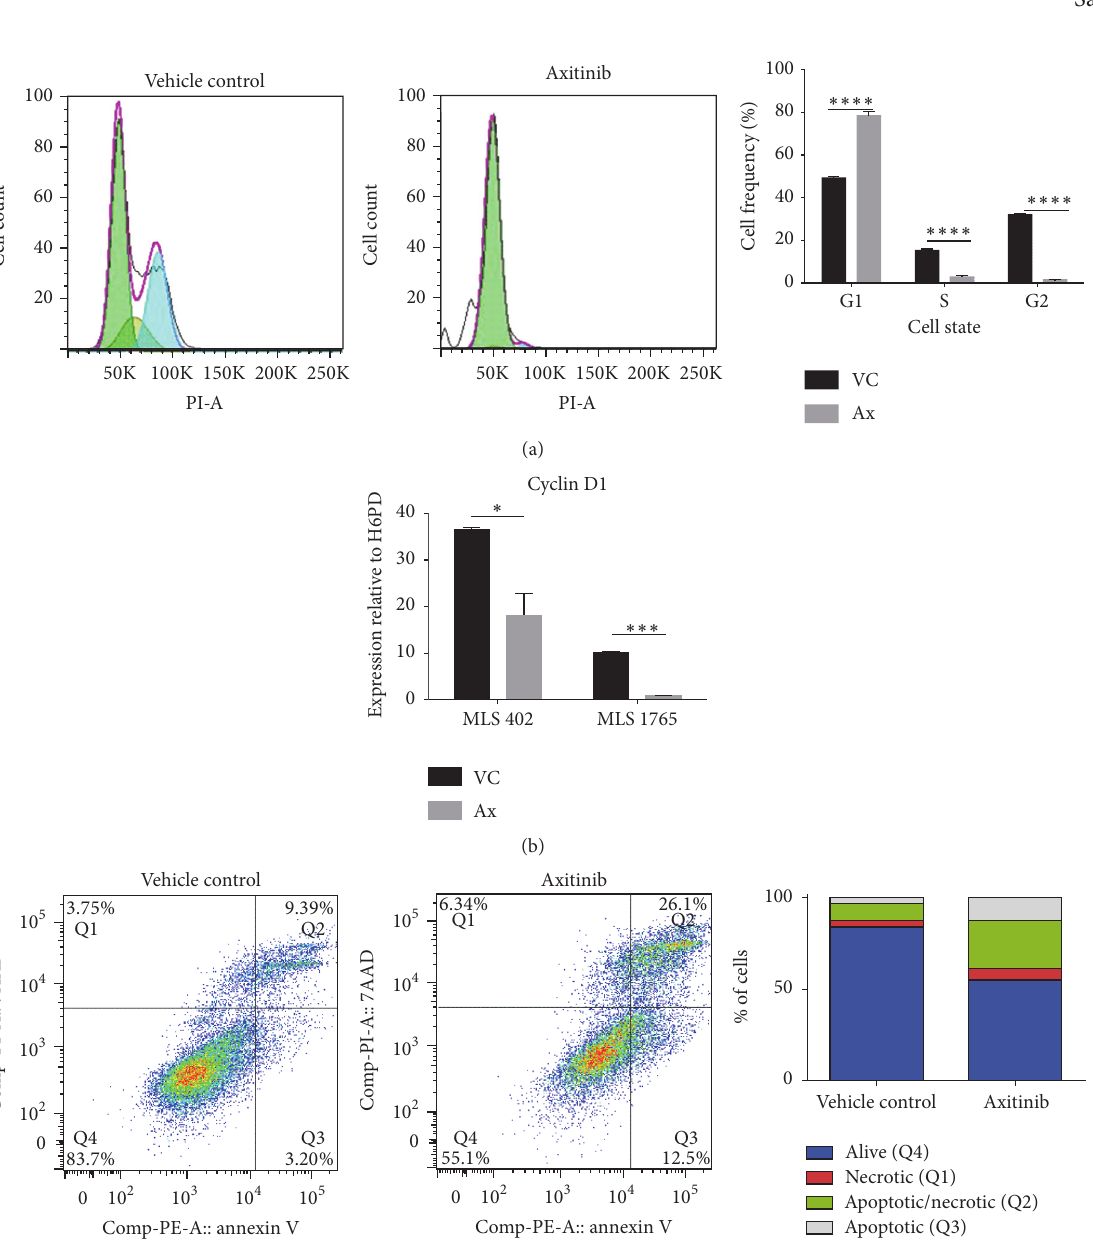
cells is still a viable option, whereas the utility of Avastin may be